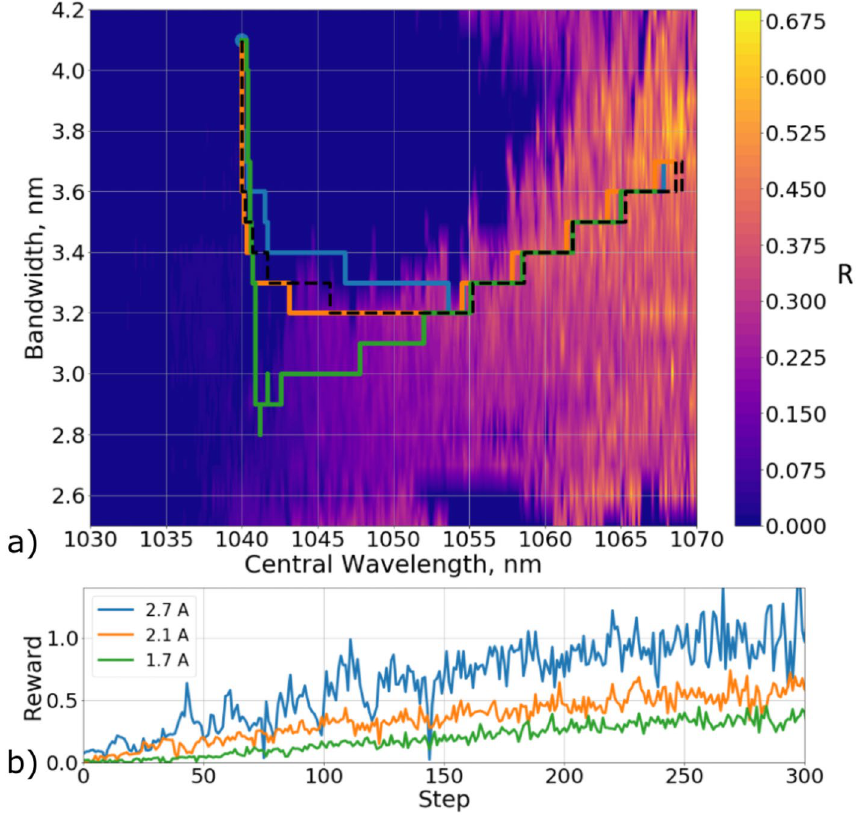
Figure 5. ( a ) The trajectories of the agent, presented on a two-dimensional map of the spaces of admissible filter values, which were obtained at different values of the pump current. Blue line - agent trajectory for 2.7 A environment, orange line - agent trajectory for 2.1 A environment, green line - agent trajectory for 1.7 A environment, doted line - agent trajectory for the model of environment. The color of the map shows the values of the immediate reward, which was calculated on the collected data at a pump diode current of 2.1 A. ( b ) The value of the immediate reward depending on the step number of the